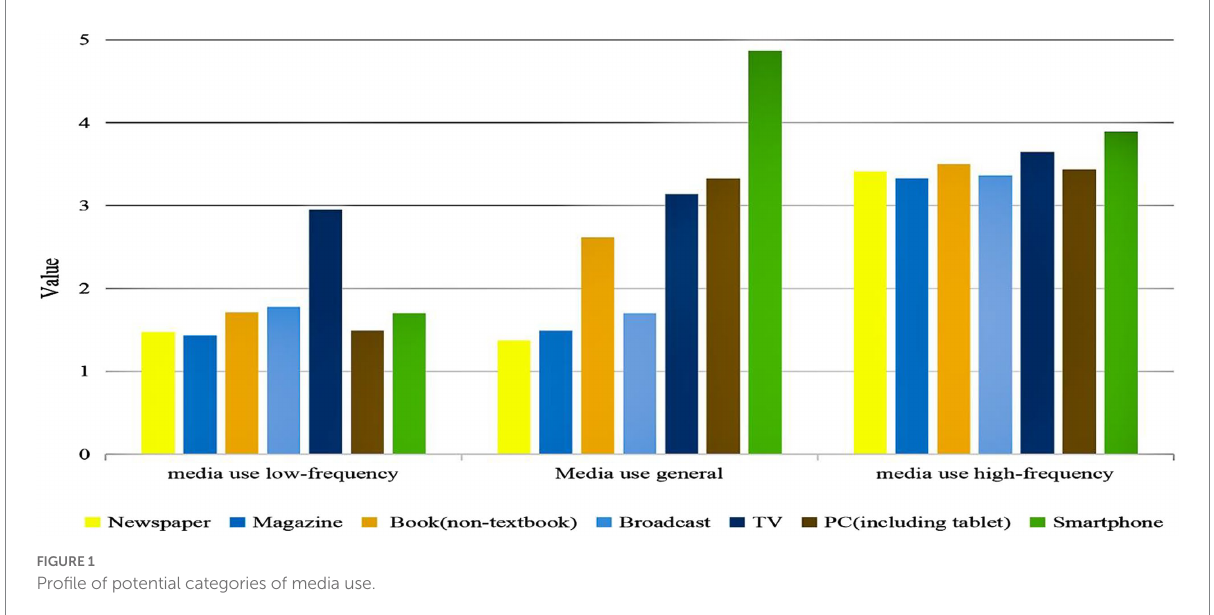
FIGURE 1 Profile of potential categories of media